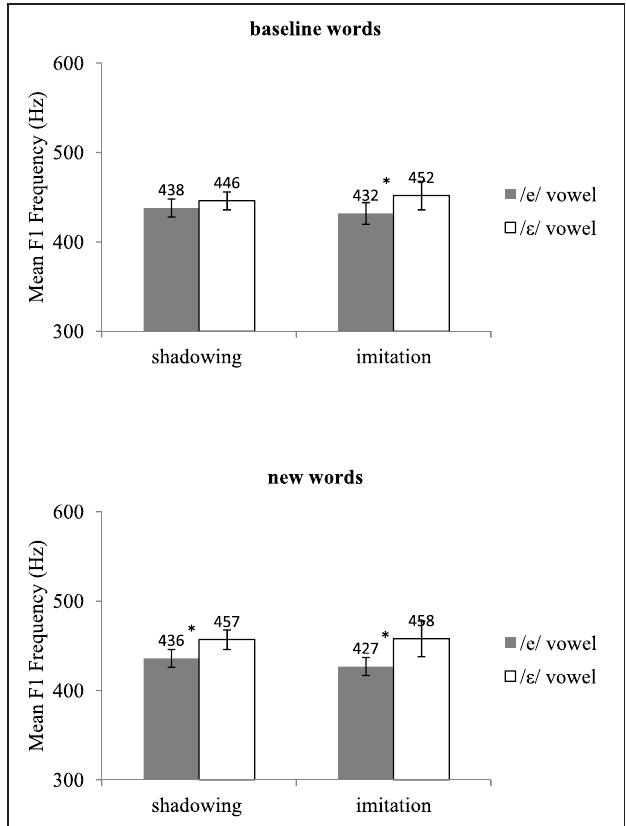
FIGURE 3 | Mean F 1 frequencies and standard errors for the /e/ and / ε / vowels in the shadowing and imitation groups for the post-test. The label baseline words refers to the words used in the pre-test, and the label new words refers to the words that were used in the test and post-test only. ∗ lndicates a significant difference between the /e/ and / ε /